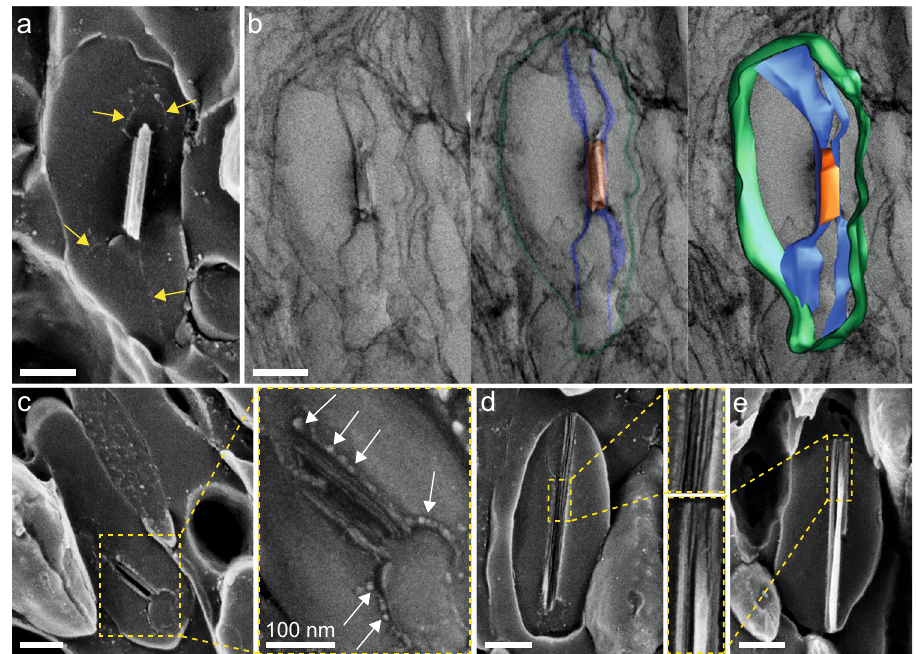
Fig. 4 | Intraluminal sheets control crystal nucleation and growth. Electron microscopy images of iridosomes from a juvenile scallop eye 200 µ m in diameter. a Cryo-SEM micrograph of an immature guanine crystal sandwiched between two intraluminal fi brils (yellow arrows). b Left; TEM micrograph of an iridosome con- taining an immature guanine crystal. Middle; pseudo-colored rendering of the same iridosome (green; iridosome membrane, blue; intraluminal sheets, orange;